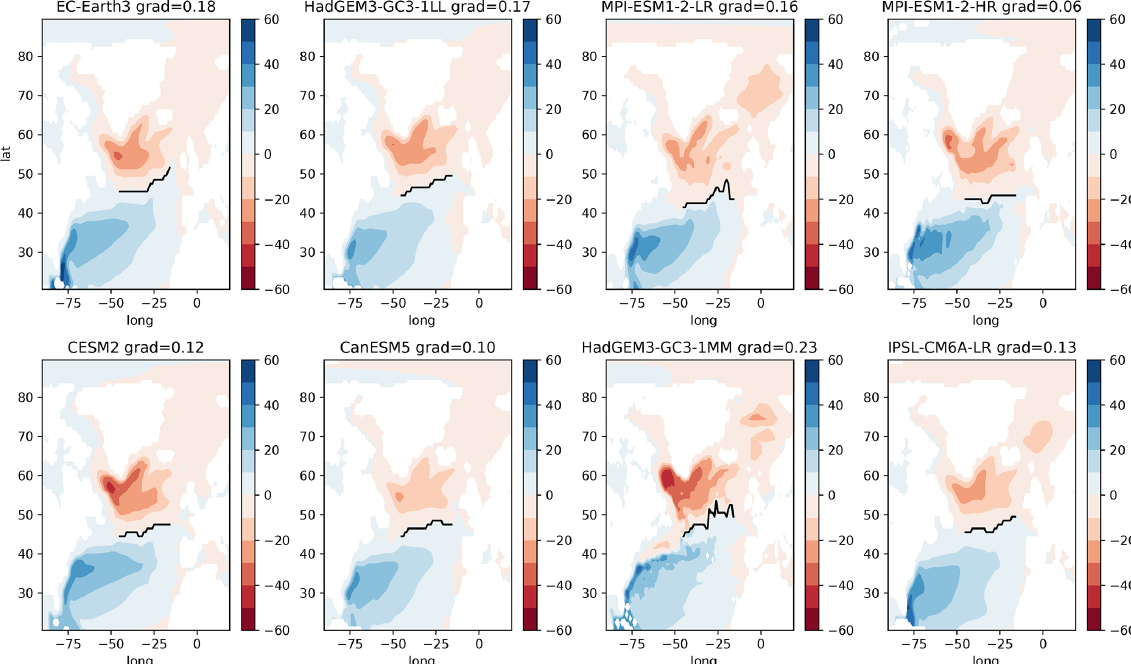
Figure 11. Time mean barotropic stream function (Sv) in the control experiments. Models in the upper panels are those where the AMOC always recovers during subsequent recovery experiments, and models in the bottom panels are those where the AMOC stays in a weak state in at least one experiment. Black lines show the intergyre boundary between the subtropical and subpolar gyres over 15–45 ◦ W, with the gradient of the boundary listed in the panel titles (degrees latitude per degrees